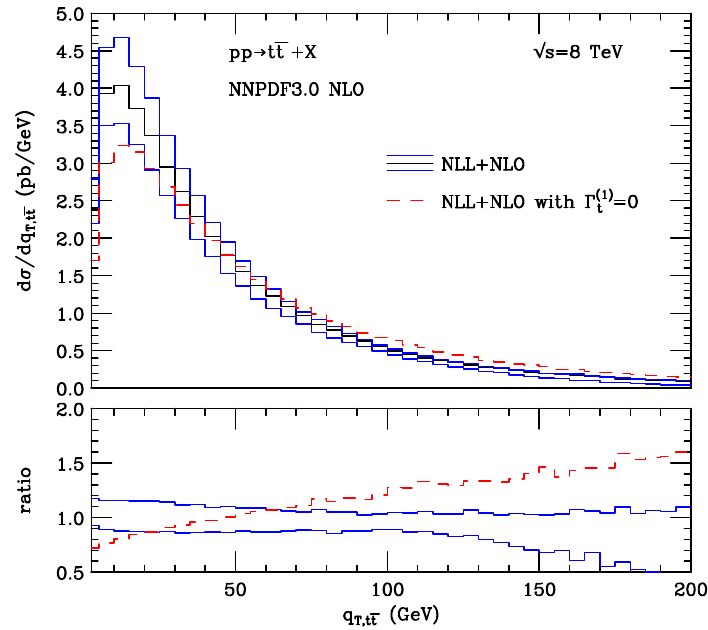
JHEP11(2018)061 Figure 8. The transverse-momentum cross section dσ/dq T of the t ¯ t pair at the LHC ( √ s = 8 TeV). The scale dependent result at NLL+NLO accuracy (solid) is compared with the ‘modified’ result (dashed) that is obtained by removing the resummed contribution of soft wide-angle radiation (which is given by the soft anomalous dimension Γ (1) ) at central scales ( µ R = µ F = Q = m t ). The t lower panel presents the ratios of the NLL+NLO scale dependence and of the ‘modified’ result with respect to the NLL+NLO result at central